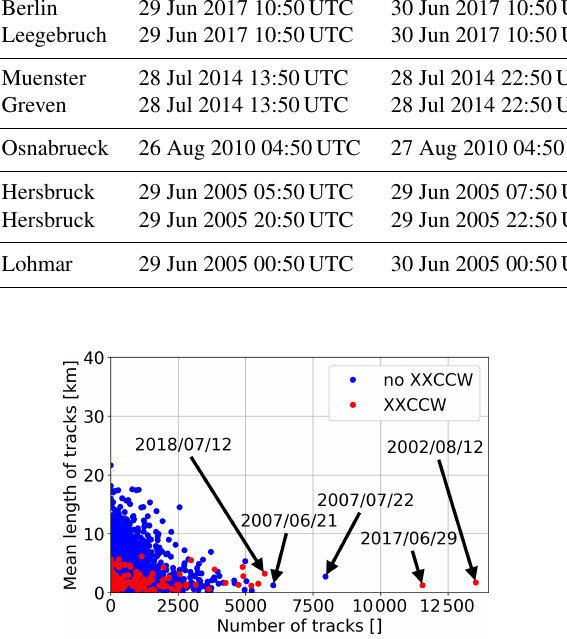
Figure 7. Cell track characteristics (mean length and number of tracks) for the research area Berlin and surroundings for days from 2001 to 2020. Colour coding identifies if days have been clas- sified as weather type “no prevailing wind direction, cyclonic circu- lation in 950 and 500hPa and above-average humidity content of the troposphere – XXCCW” or another type – not XXCCW (Bissolli and Dittmann, 2001). Arrows indicate days with flooding events in